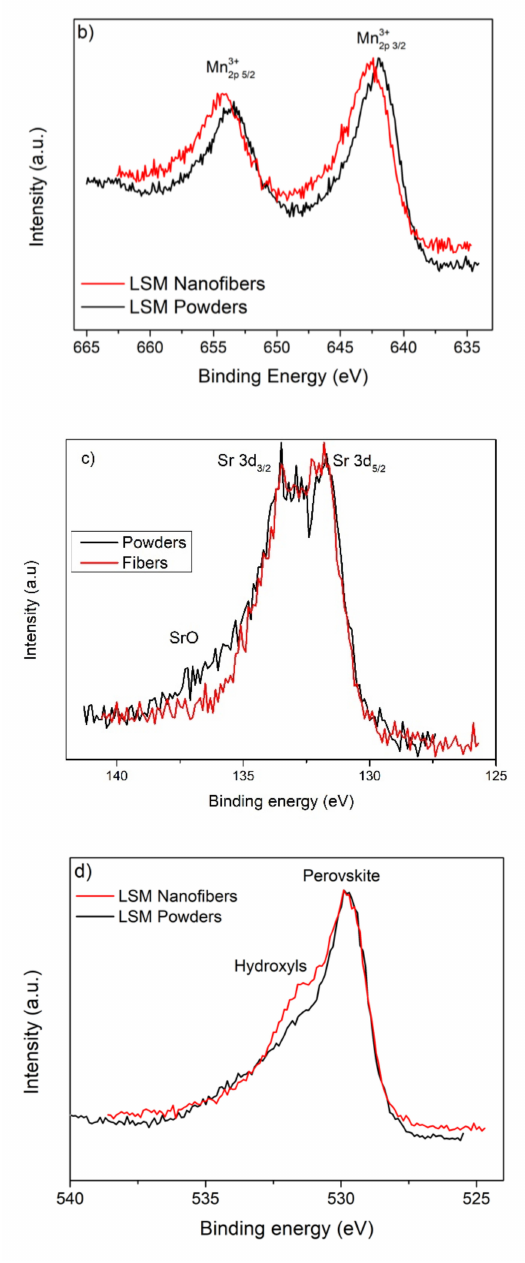
Figure 4. XP spectra of LSM samples prepared, respectively, by citrate gel method (black line) and electrospinning (red line) (the spectra are normalized with respect to their maximum value): ( a ) La 3d; ( b ) Mn 2p; ( c ) Sr 3d; ( d ) O